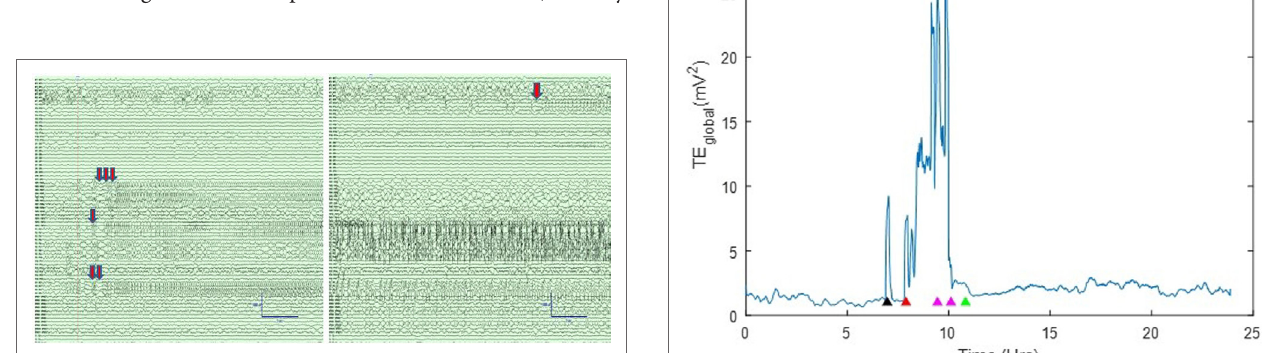
FigUre 3 | Spatial average of Teager energy across brain sites (TE global ) over the entire 24 h iEEG recording from PT1. The black arrow, about 7 h into the recording, indicate the timing of a pre-status epilepticus (pre-SE) clinical seizure; the red arrow indicate the onset of SE; the magenda arrows indicate the times of the administered anti-SE medical intervention; the green arrow indicate the clinically assessed onset of recovery from SE. TE global attains high values at the occurrence of the pre-SE clinical seizure as well as at the onset and during most of SE.